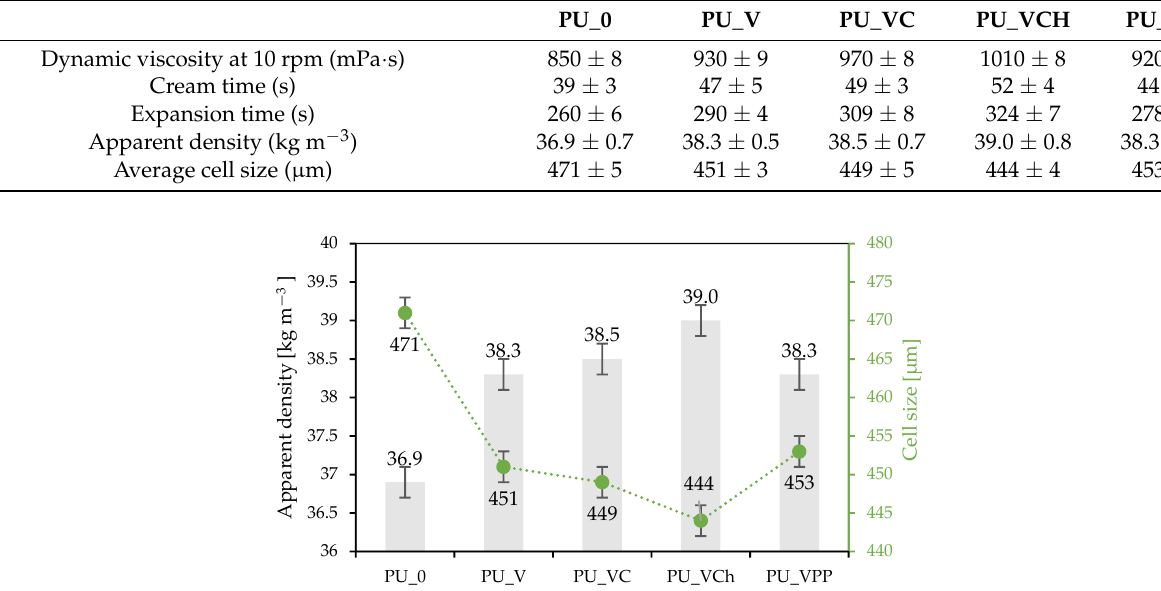
Table 1. Rheological properties of polyurethane composites. Figure 3. Results of apparent density and average cell size of the PU composites.